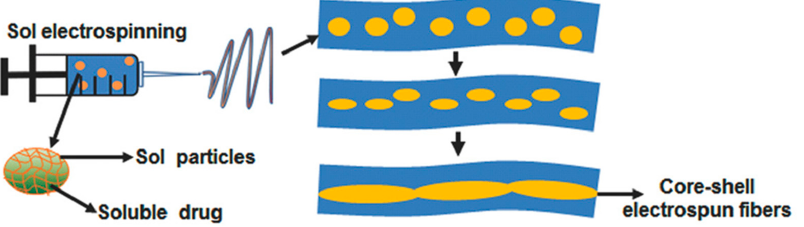
Figure 5. Schematic illustration of core-shell electrospun fibres containing GEM. GEM ‒ HA ‒ sol was firstly dispersed into PLA solution to form an electrospinning solution. Under the application of electrospinning technique, GEM-containing core-shell electrospun fibres are formed, namely GEM@PLA ‒ HA. Reprinted with permission from Xia et al. [125]. 2022, John Wiley and Sons.